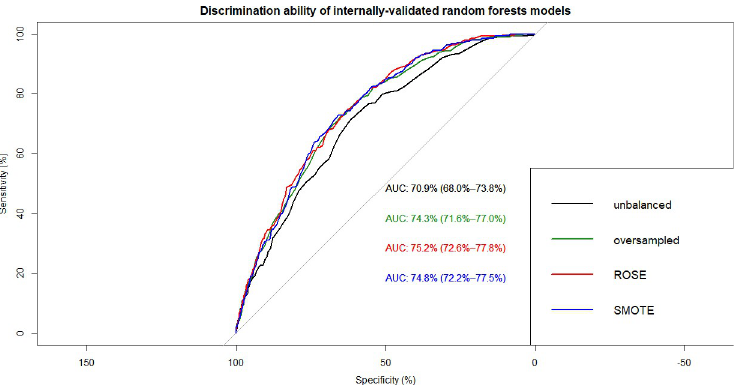
Fig 4. Overlapped ROC curves demonstrating predictive performance of random forests models on internal validation data. Using unbalanced, original training data and re-structured with oversampling, ROSE and SMOTE resampling.